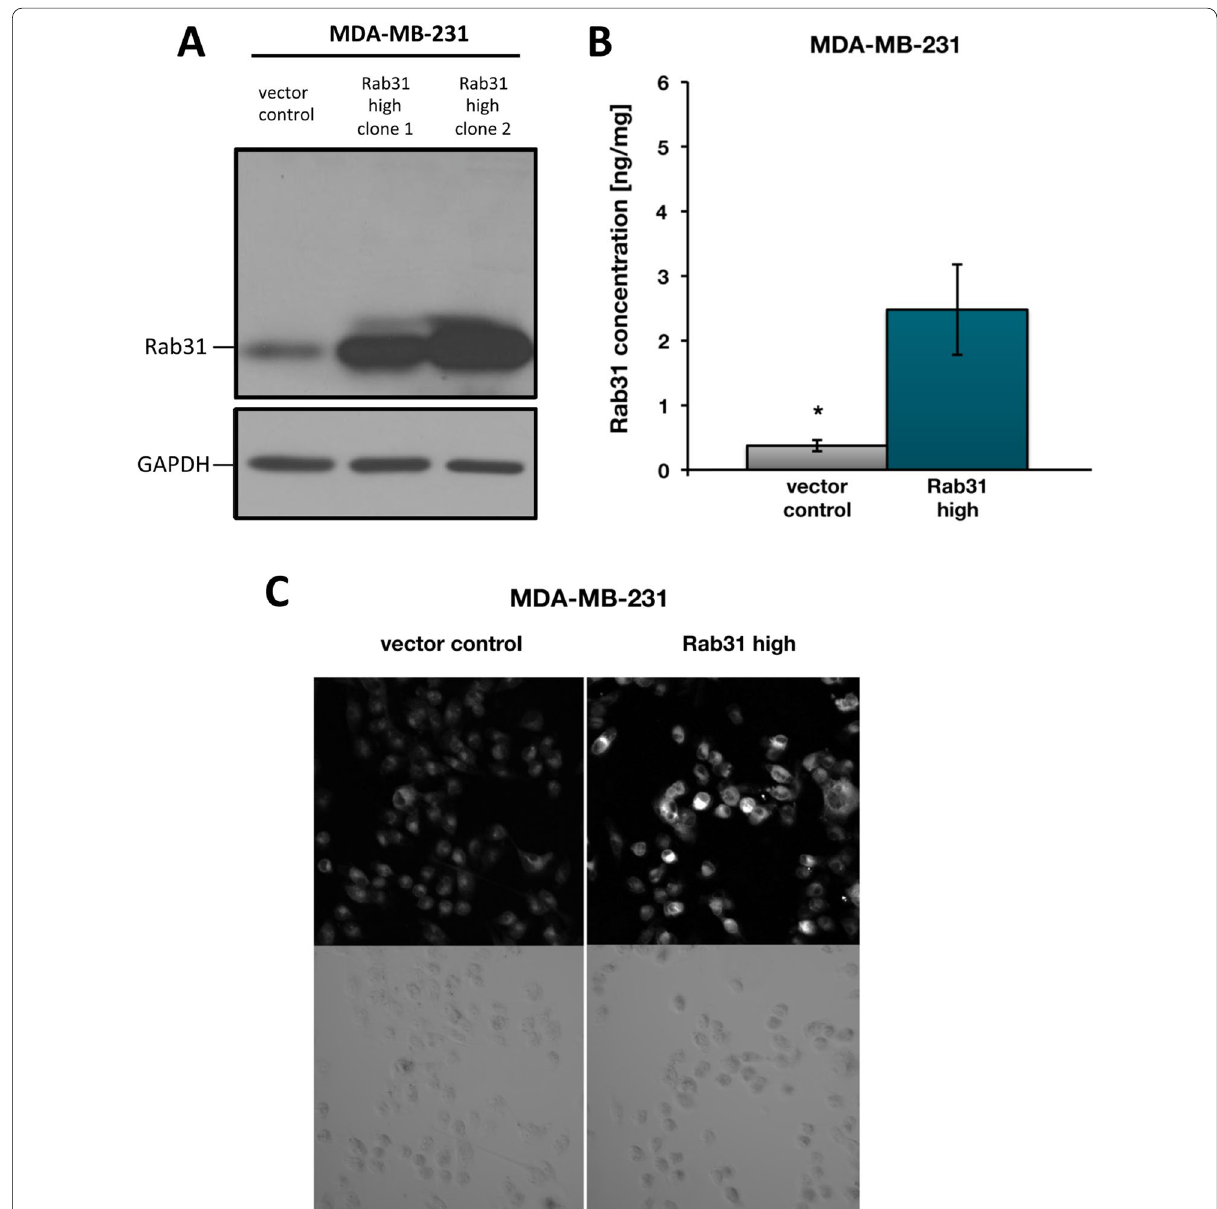
Fig. 4 Characterization of MDA-MB-231 breast cancer cells stably transfected with Rab31. MDA-MB-231 breast cancer cells were stably transfected with either the plasmid pRcRSV-Rab31 or with the vector alone. A Western blot analysis. In addition to vector control cells, the Western blot shows two independently selected Rab31-overexpressing MDA-MB-231 cell clones. Clone 2 was used for all further experiments described in the manuscript. GAPDH expression served as loading control. B Rab31 antigen levels in cell culture lysates, determined by ELISA. At least three experiments were performed in triplicates each. Statistically significant differences (p < 0.05) are indicated by an asterisk. C Immunocytochemical analysis of Rab31. Rab31 protein expression is presented in white in the upper panels. The lower panels show transmission images of the